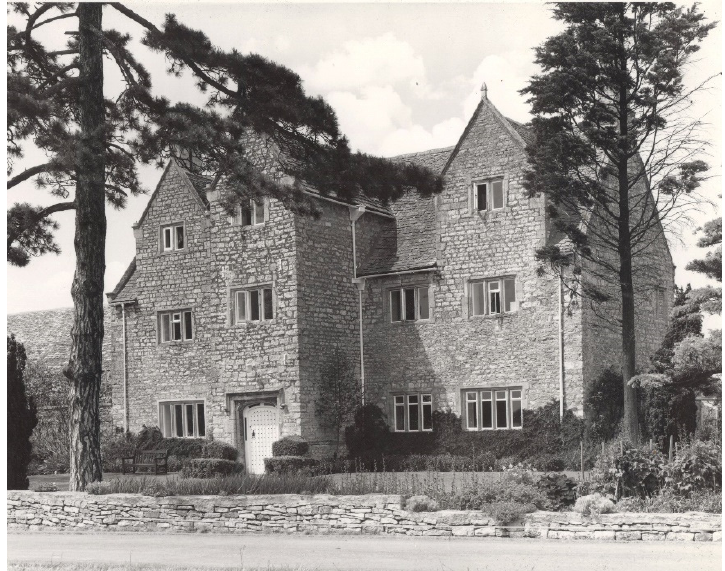
Figure 1. Weed Research Organisation, Begbroke Hill, Oxford, closed 1985. There were modern labs behind.